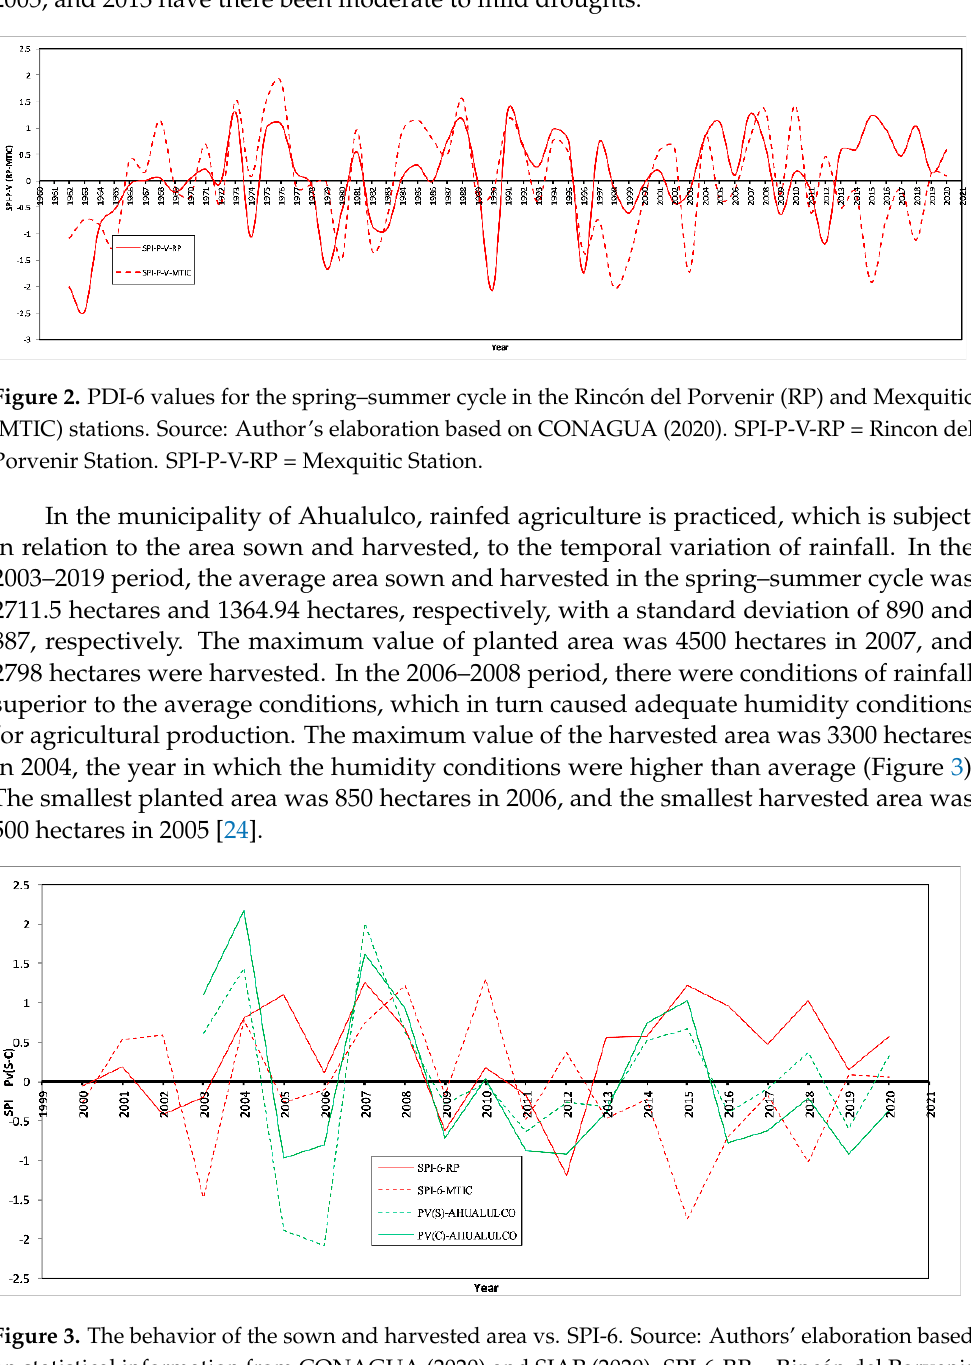
Figure 3. The behavior of the sown and harvested area vs. SPI-6. Source: Authors’ elaboration based on statistical information from CONAGUA (2020) and SIAP (2020). SPI-6-RP = Rincón del Porvenir station. SPI-6-MITIC = Mexquitic station. PV (S)-AHUALULCO = normalized value of the area sown in the spring–summer cycle in the municipality of Ahualulco. PV (C)-AHUALULCO = normalized value of the harvested area in the spring–summer cycle in the municipality of Ahualulco.